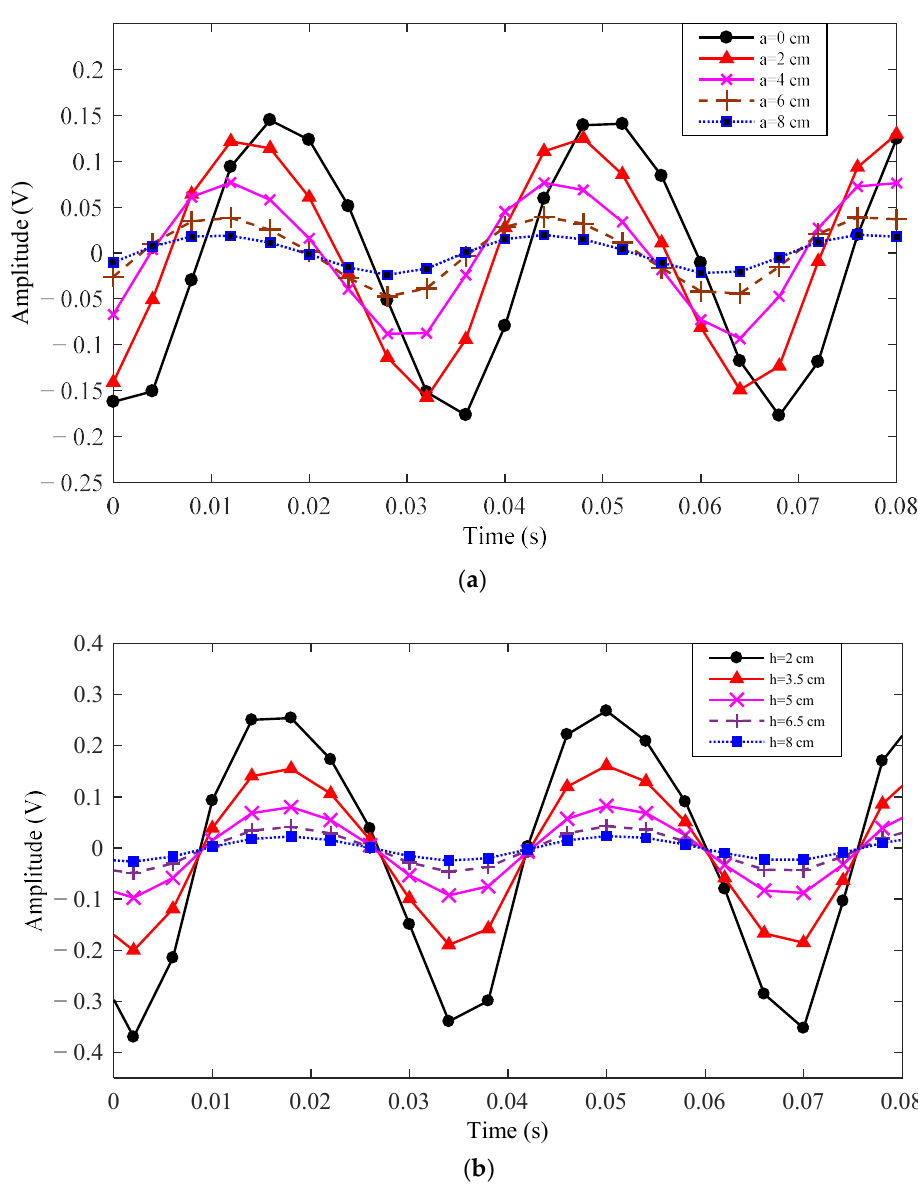
Figure 4. V o as functions of a and h : ( a ) V o as a function of a for b = 3 cm, h = 4 cm; ( b ) V o as function of h for a = 2 cm, b = 3 cm.